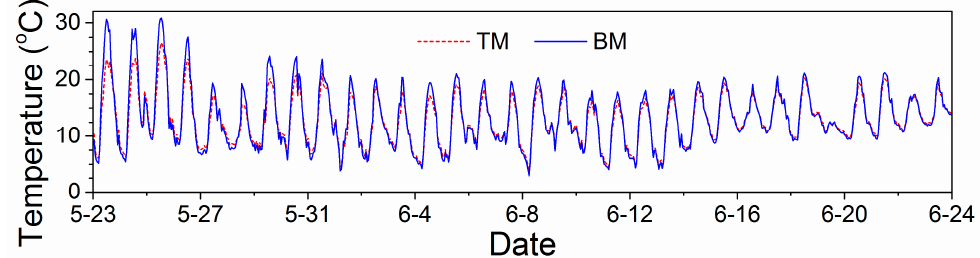
Figure 11. Simulated hourly canopy temperature of potato plants grown with transparent plastic film mulch (TM) and black plastic film mulch (BM) at Wuwei, China, in